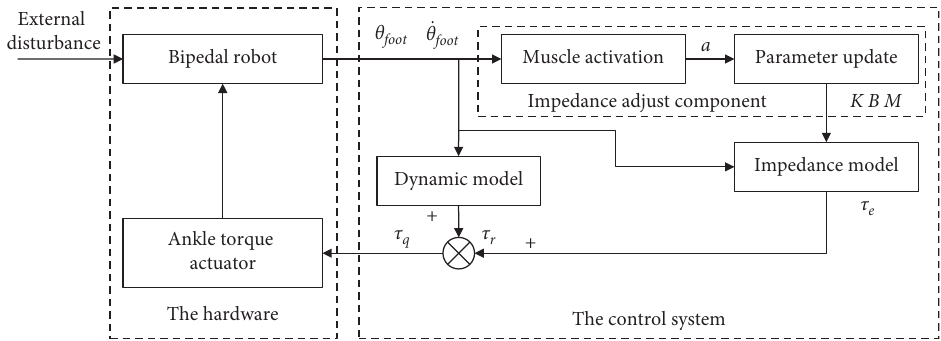
Figure 1: The framework of variable impedance control for bipedal robot standing balance control.